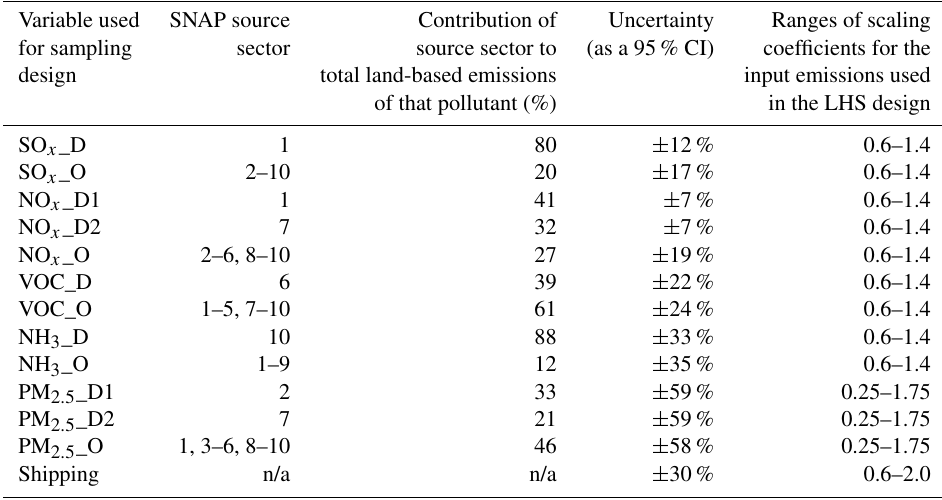
Table 2. Input variable definitions for the EMEP4UK uncertainty propagation and apportionment. The quoted uncertainties for emission sources are for UK annual totals. See main text for information on the sources of these values. Variable used SNAP source Contribution of Uncertainty Ranges of scaling for sampling sector source sector to (as a 95% CI) coefficients for the design total land-based emissions input emissions used of that pollutant